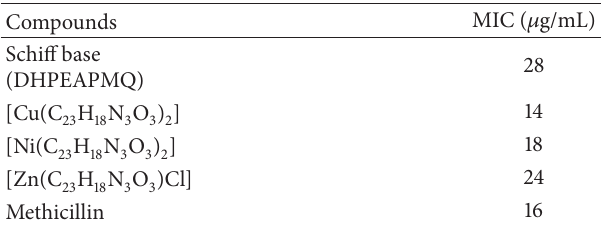
Table4:MICvaluesofSchiffbase(DHPEAPMQ)anditscomplexes against